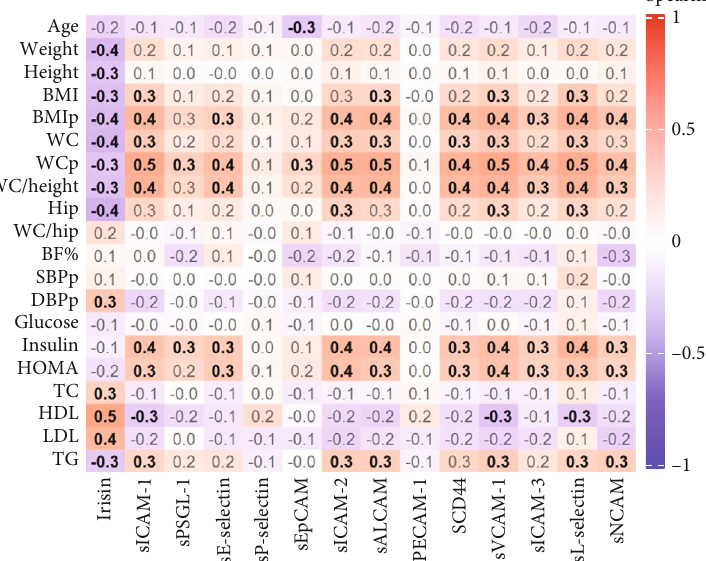
Figure 2: Correlation heat map for irisin and adhesion molecules with anthropometric and biochemical parameters in children and adolescents with type 2 diabetes mellitus, metabolic syndrome, and healthy controls. Colored squares of the heat map represent Spearman ’ s rho correlation coe ffi cients; the coe ffi cients ’ font appears black and bold when correlations are statistically signi fi cant and grey when they are not. Squares fi lled in shades of blue represent negative correlations, while those fi lled in shades of red represent positive correlations. Statistical signi fi cance was established as p value ≤ 0.05. BMI: body mass index; BMIp: BMI percentile; WC: waist circumference; WCp: waist circumference percentile; BF%: body fat percentage; SBPp: systolic blood pressure percentile; DBPp: diastolic blood pressure percentile; HOMA: Homeostatic Model Assessment; TC: total cholesterol; HDL: high-density lipoprotein cholesterol; LDL: low-density lipoprotein cholesterol; TG: triglycerides; sICAM: soluble intercellular adhesion molecule; sPSGL: soluble P-selectin glycoprotein ligand; sEpCAM: soluble epithelial cell adhesion molecule; sALCAM: soluble activated leukocyte cell adhesion molecule; sPECAM: soluble platelet endothelial cell adhesion molecule; sVCAM: soluble vascular cell adhesion molecule; sNCAM: soluble neural cell adhesion